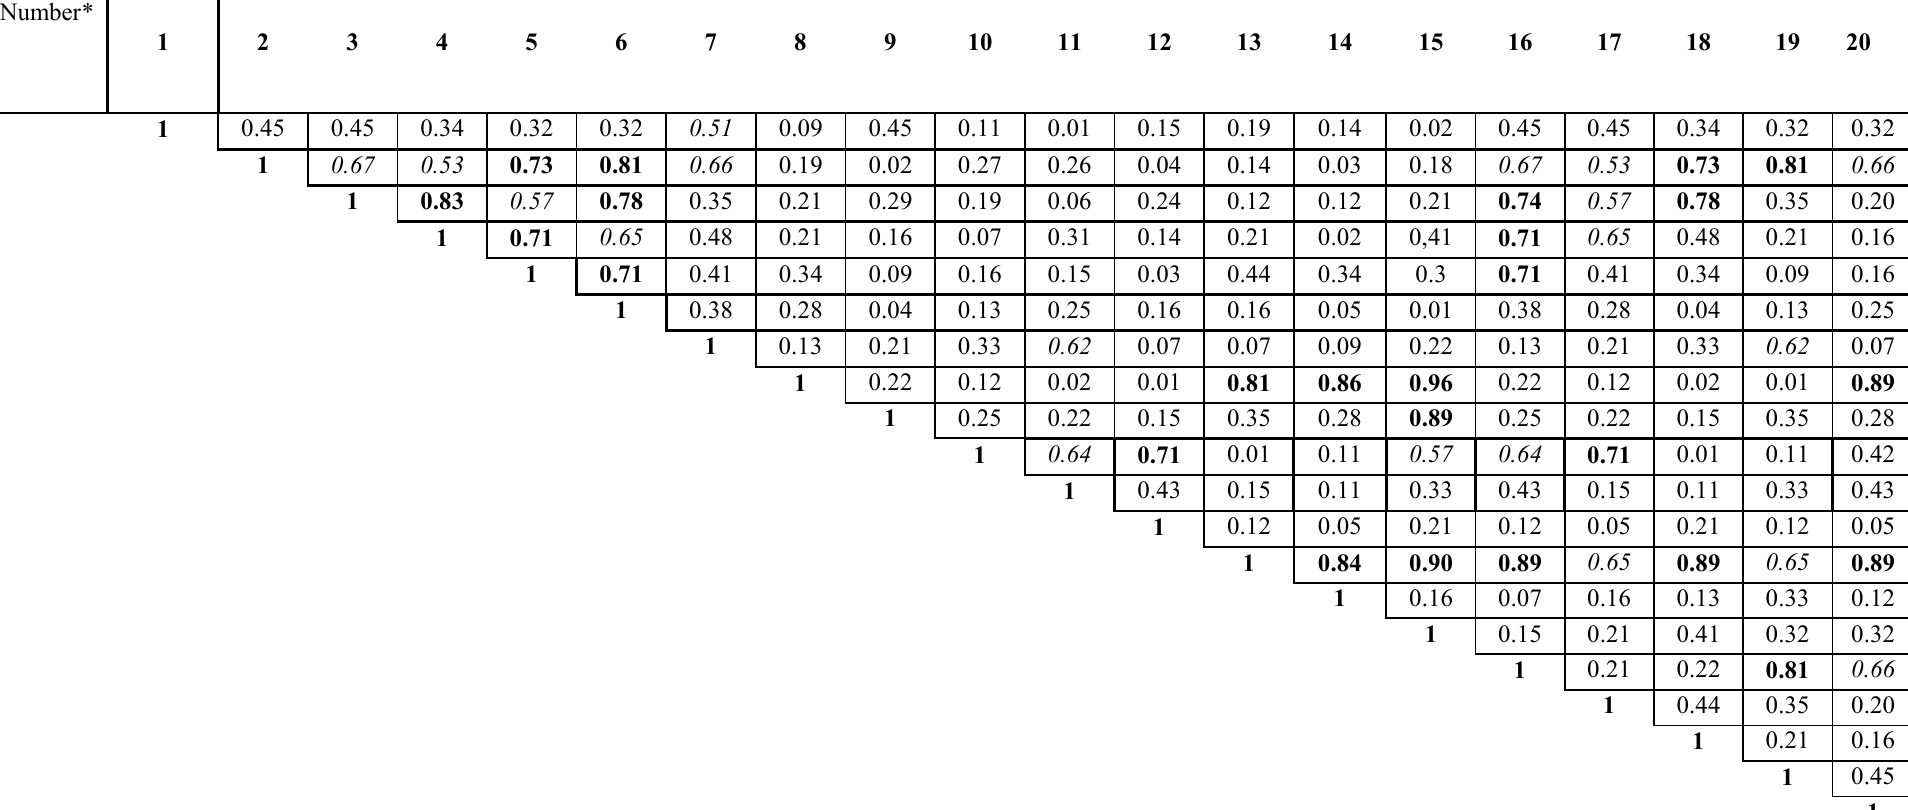
Correlation field of cheerleaders’ special physical fitness (n=14;